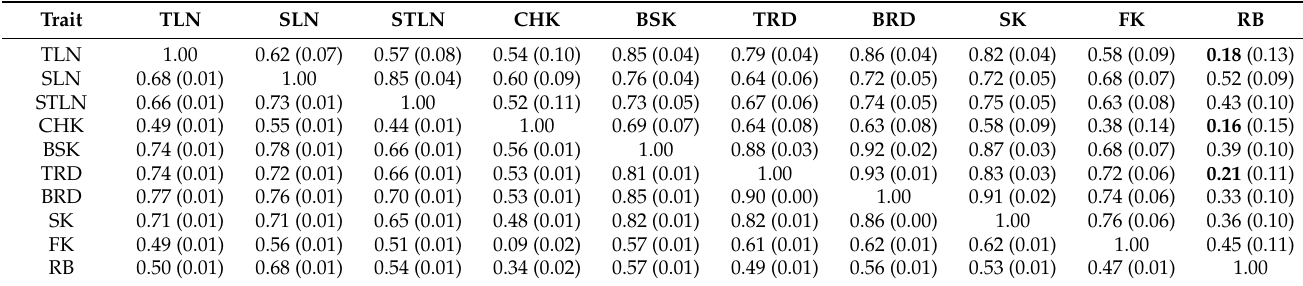
Table 3. Estimates of genetic (above diagonal) and phenotypic (below diagonal) correlations (standard error (SE) in parentheses) among the primal cut yields in Hanwoo cattle.